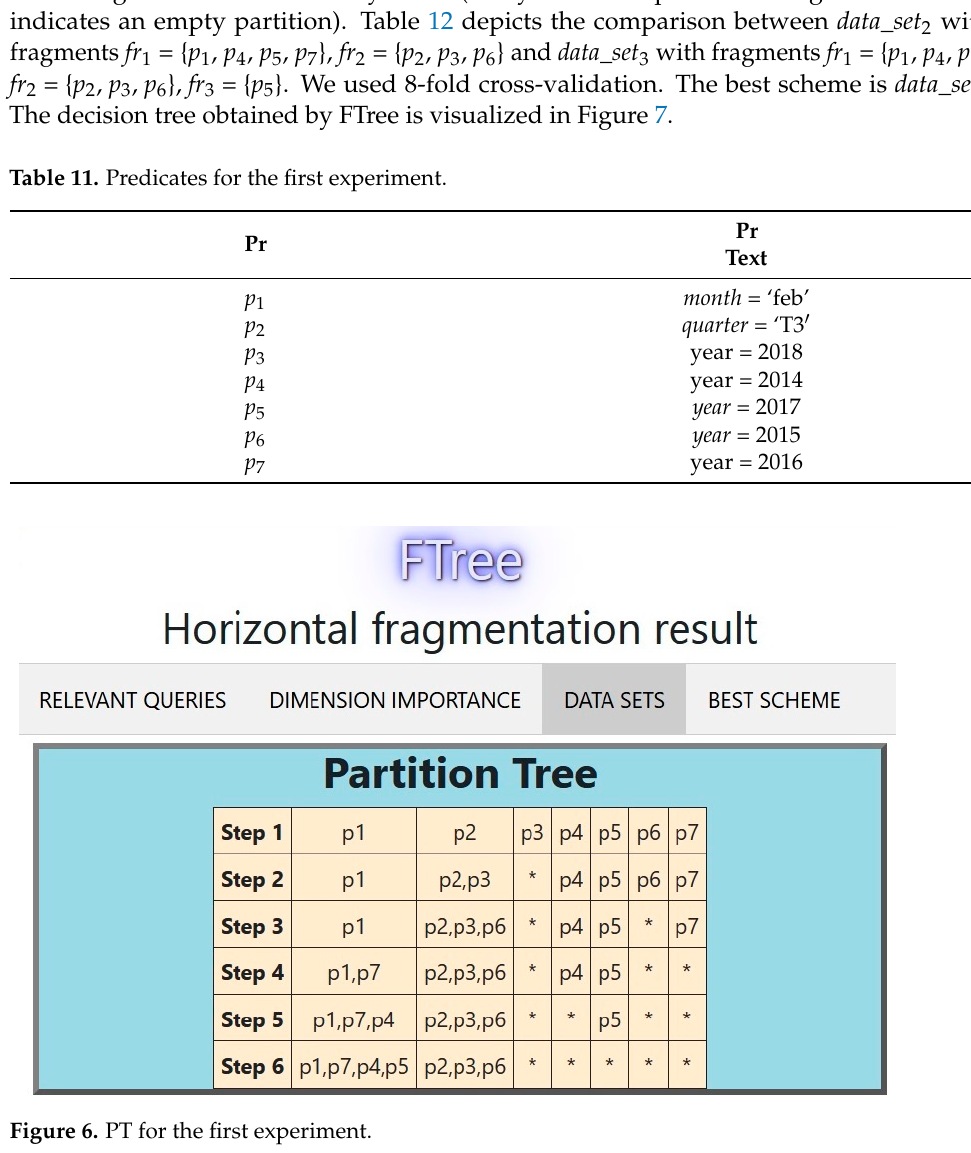
Figure 6. PT for the first experiment.